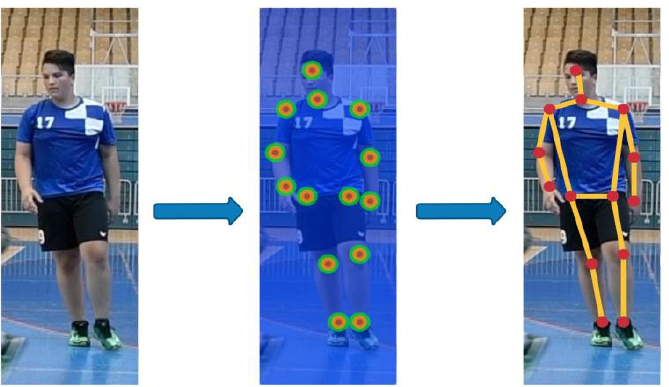
Figure 4. Heatmap poses estimation. It starts by creating heatmaps of all keypoints within the image, and then additional methods are used to construct the final stick figure.